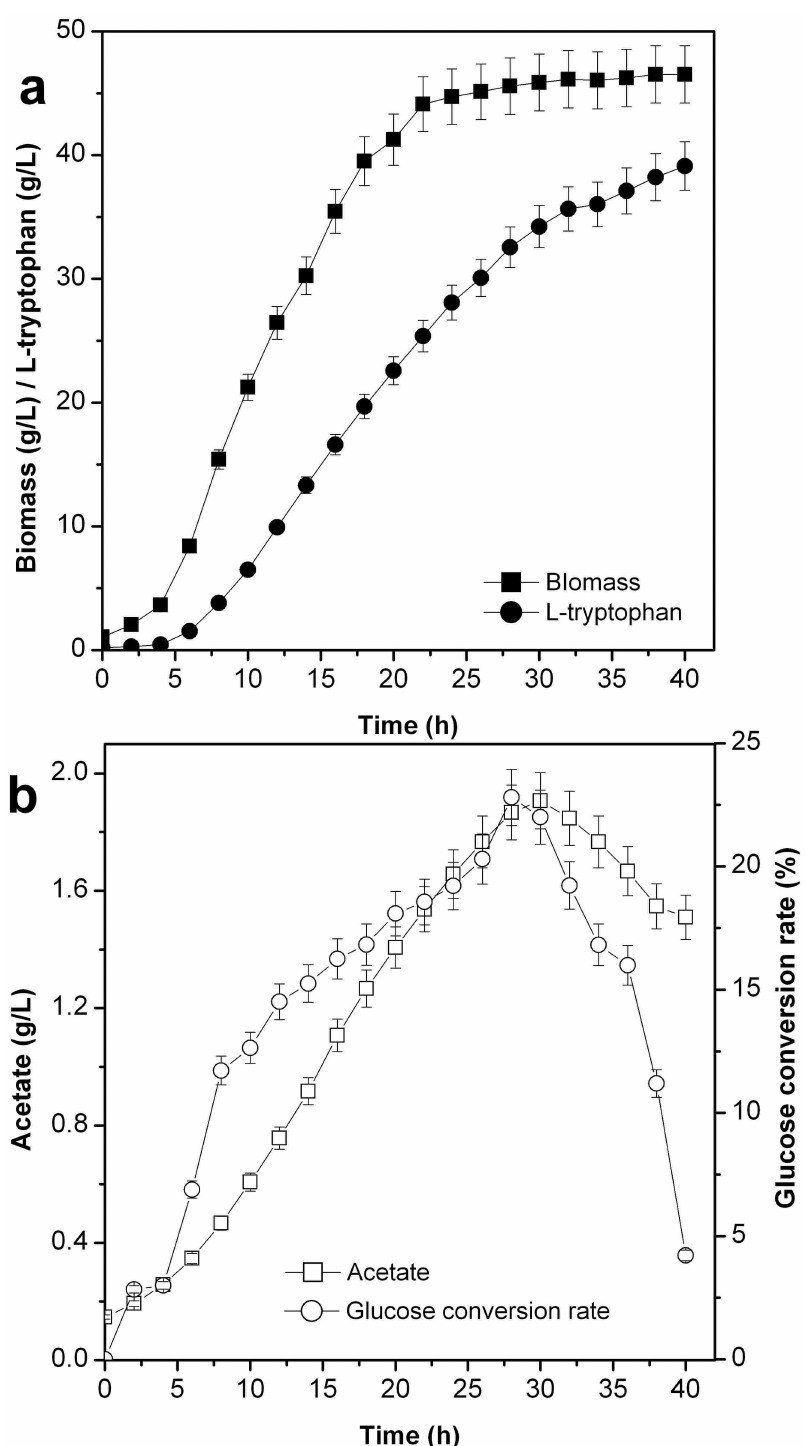
Fig 2. Analysis of process parametersin L-tryptophan production by using the strain TRTHB ( P < 0.05).